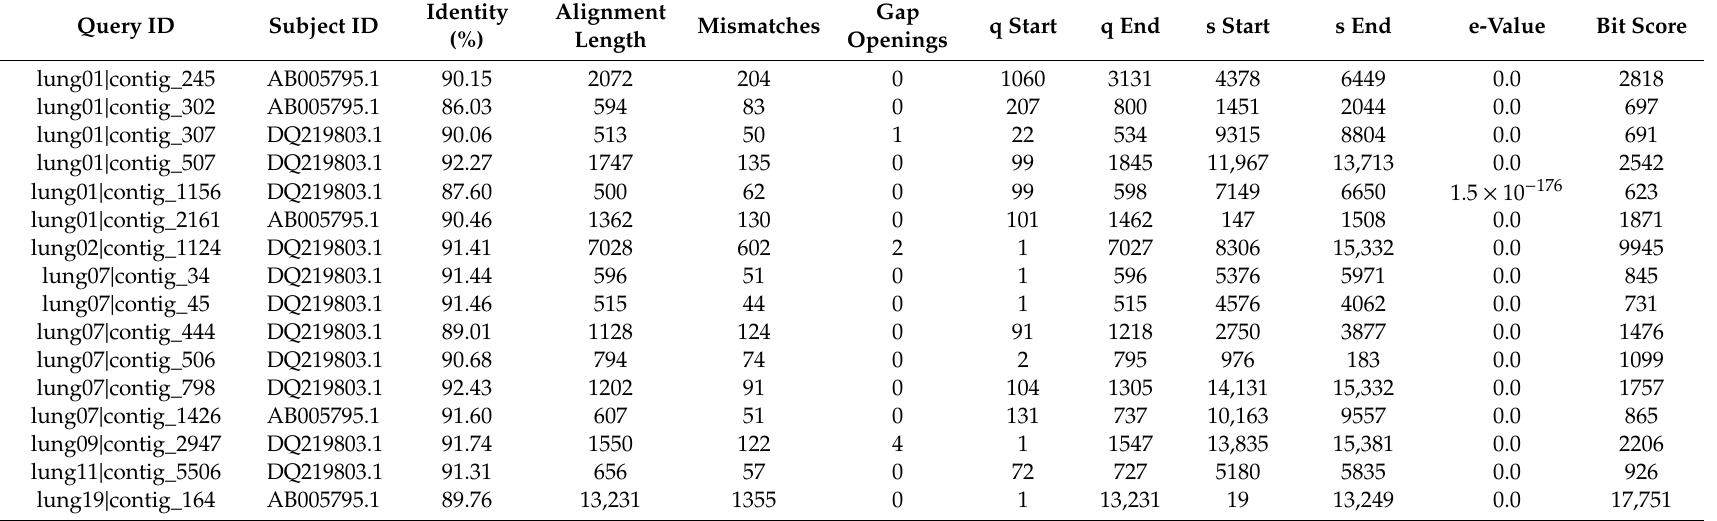
Table 2. Information of contigs with a high level of sequence similarity and then conformed as the Sendai virus. See table legend of Table S2 for detailed explanation of the table